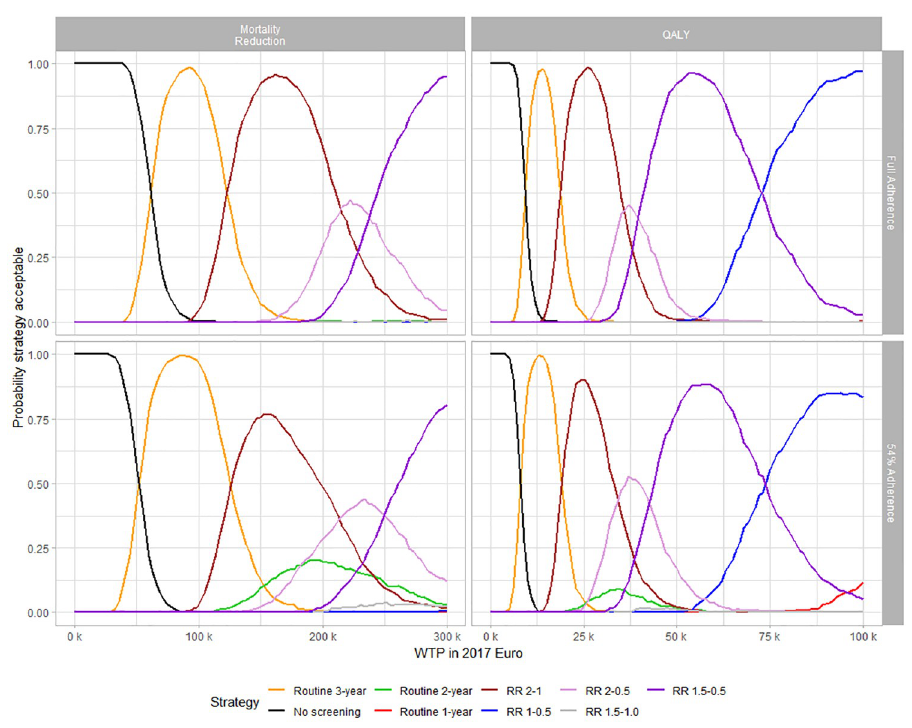
Fig 2. Cost-effectiveness acceptability